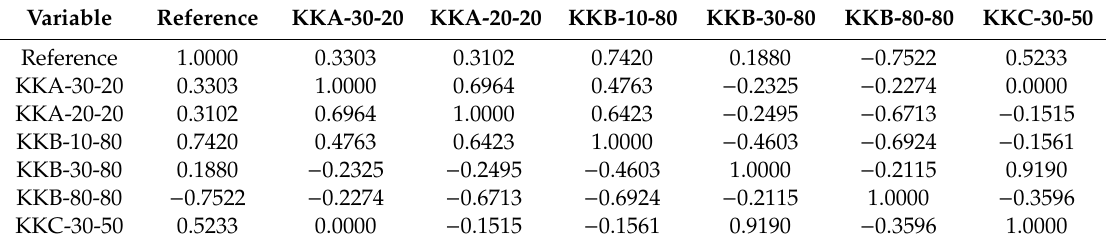
Table 9. The correlation coefficient of the tensile strength obtained under various ageing variants and in the reference condition (for significance coefficient p < 0.05).